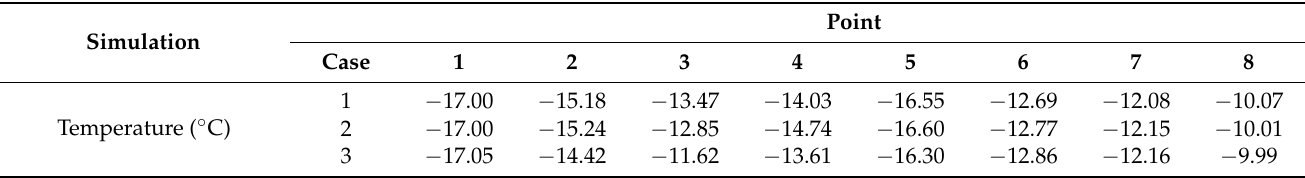
Table 3. RSME values (°C) of predicted temperatures by the developed model.